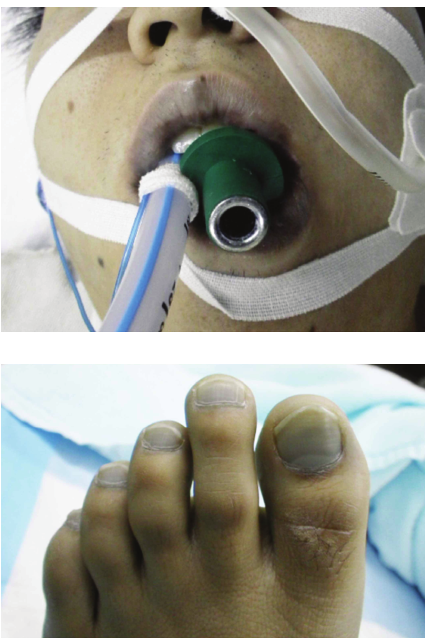
Figure1:Hisface,lips,andtoesweredeeplycyanosedonadmission.